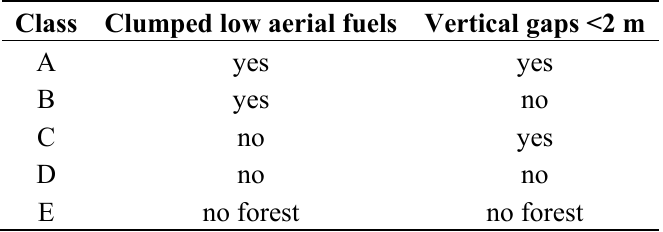
Table 2. Ladder fuel hazard assessment classes